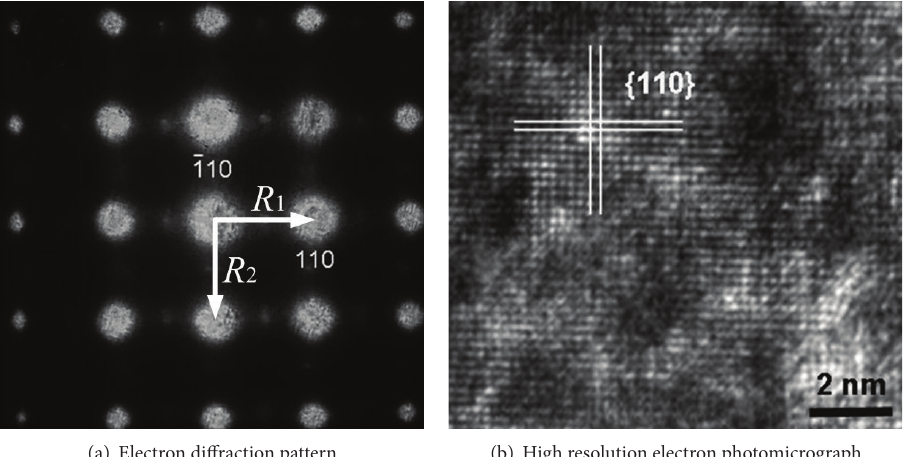
Figure 5: Calibration process of 𝛽 phase structure analysis for titanium alloy.